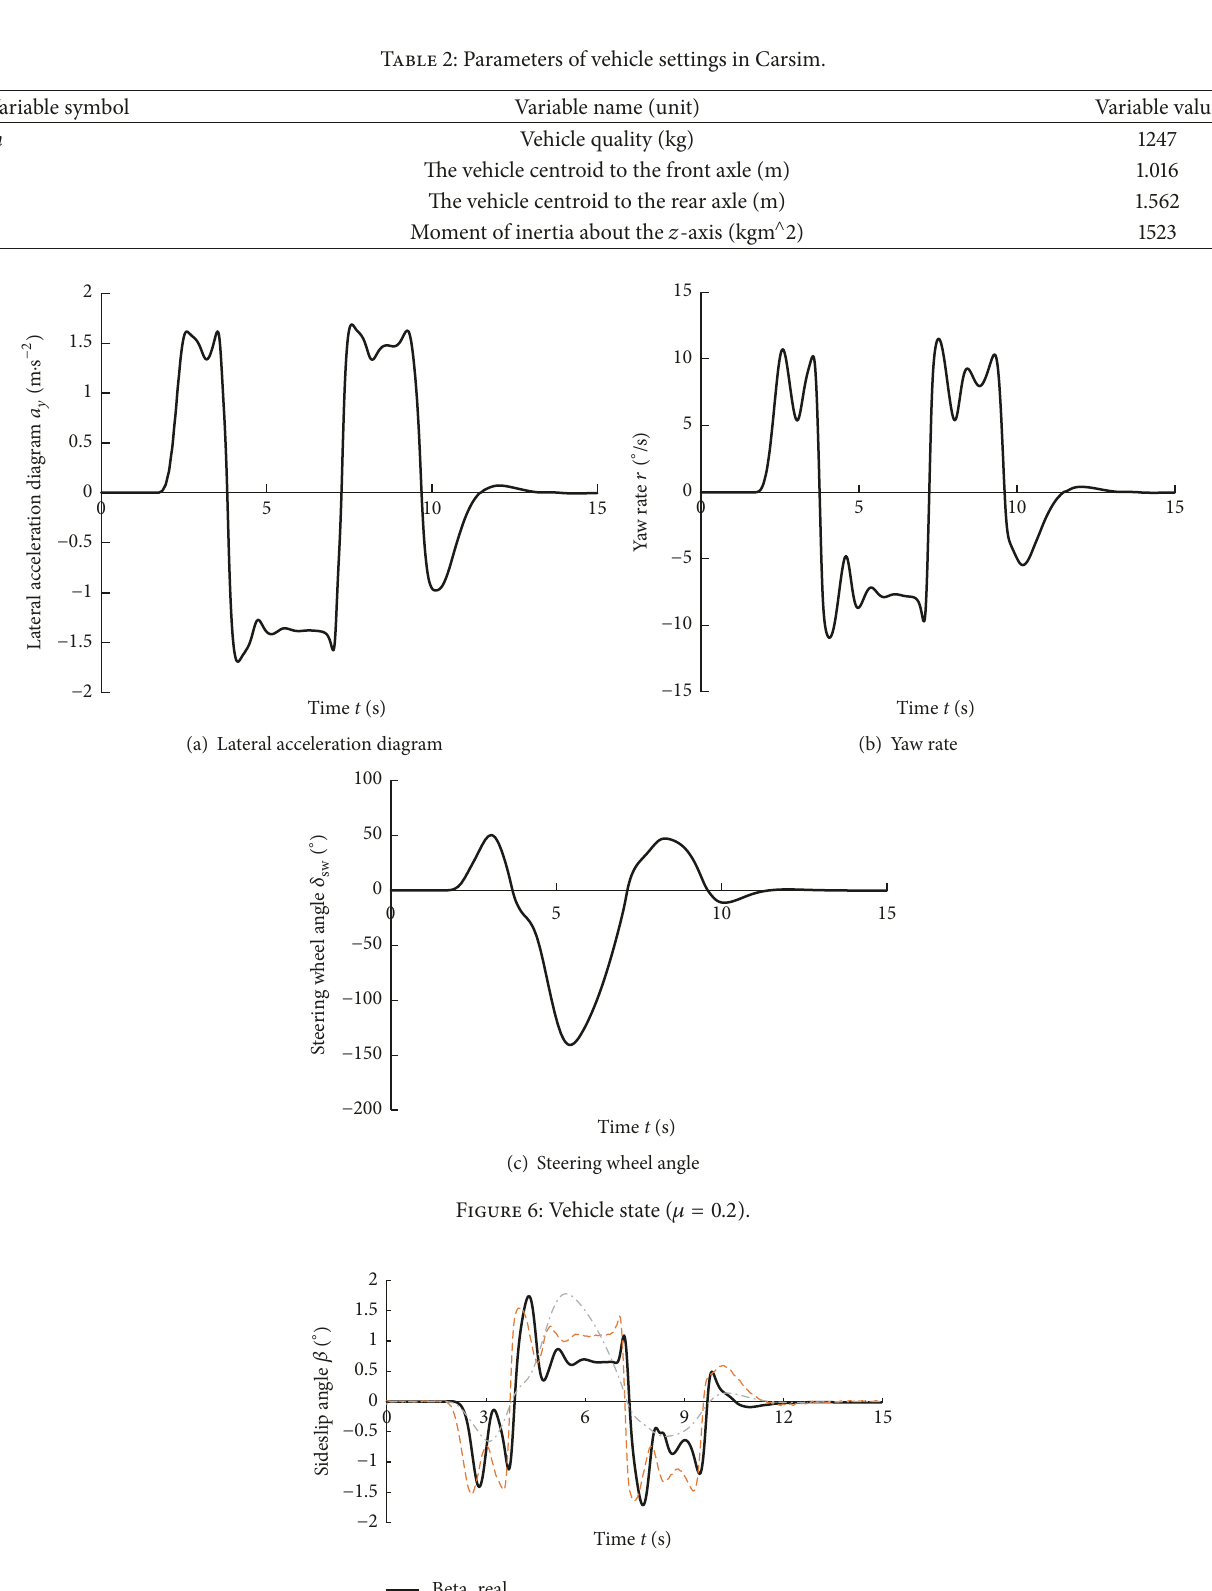
Figure 7: The contrast of sideslip angle simulation value and estimated value ( 𝜇 = 0.2